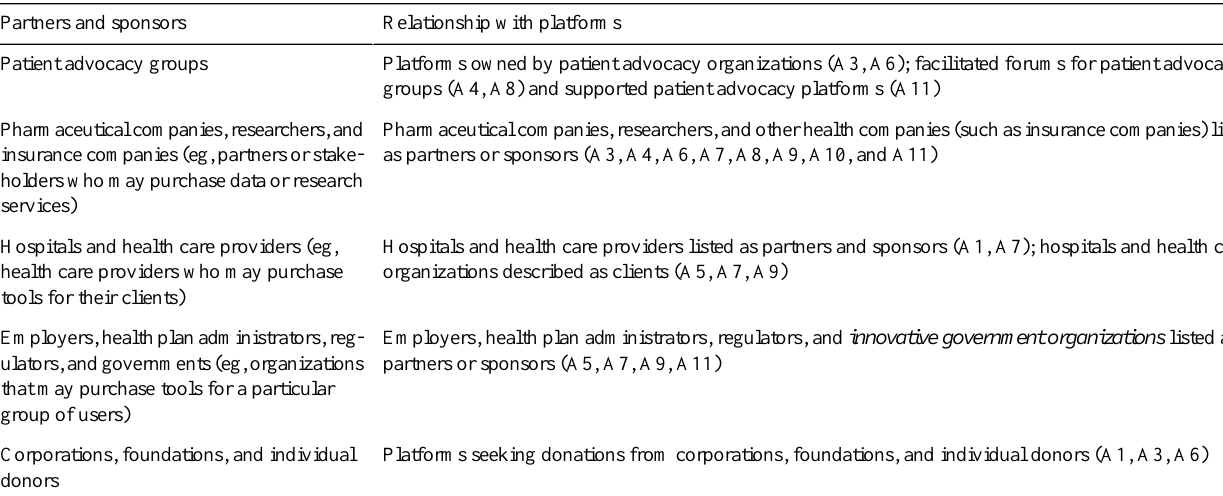
Table 4. Partners and sponsors and their relationships with platforms.